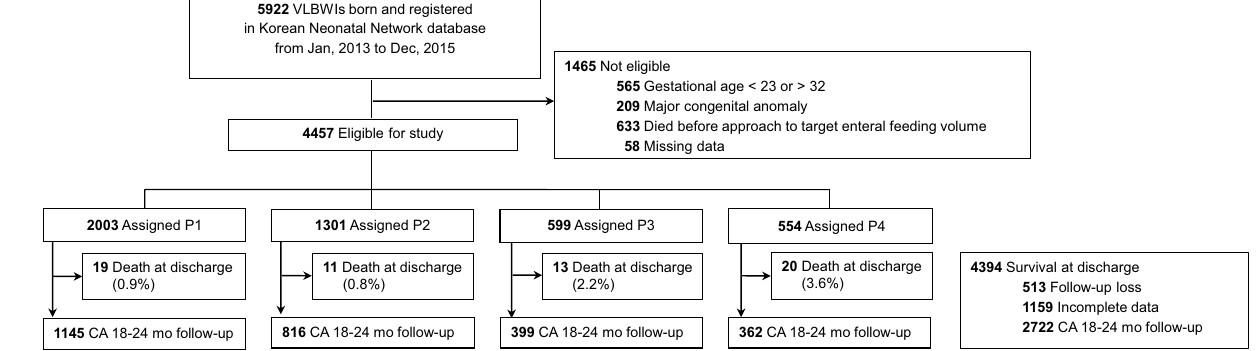
Figure 1. Flowchart identifying the study population. We categorized these eligible infants into four groups based on the time to reach full enteral feeding by 15 days increment: P1, < 16 postnatal days (PND); P2, 16–30 PNDs; P3, 31–45 PNDs; and P4, > 45 PNDs. VLBWI, Very-low-birth-weight infants; CA, corrected